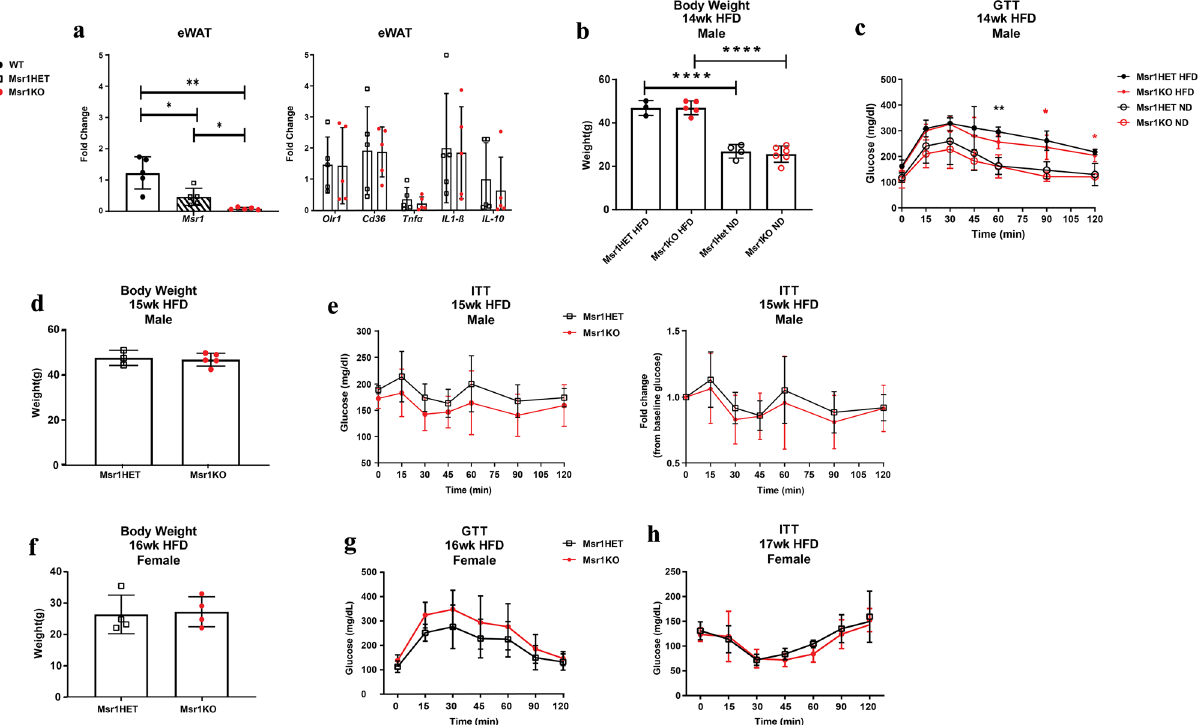
Figure 3. Msr1 is not required for obesity-induced changes in glucose metabolism ( a ) Gene expression of Msr1, scavenger receptors, and cytokines in iWAT and eWAT by qPCR from male Msr1HET (black) and Msr1KO (red) male mice. n = 5/group. * p < 0.05; Statistical Analysis = t-test. WT mice were non-littermate HFD fed controls. ( b ) Whole body weight for 14-week male ND and HFD-fed Msr1HET and Msr1KO mice at the time of ( c ) glucose tolerance test (GTT). ( d ) Whole body weight for 15-week male HFD-fed mice at the time of ( e ) Insulin tolerance test (ITT). n = 3–5 per group. ( f ) Whole body weight for 16-week female HFD-fed Msr1HET (black) and Msr1KO (red) female mice. ( g ) Glucose tolerance test (GTT) and ( h ) insulin tolerance test (ITT) after 16 and 17 weeks of HFD, respectively. HFD Msr1HET (black), HFD Msr1KO (red). n = 4/group. Statistical Analysis for weight = Ordinary one-way ANOVA. **** p < 0.0001 between Msr1KO ND and HFD groups; Statistical Analysis for GTT/ITT = 2-way ANOVA multiple comparisons. ** p < 0.05 between ND and HFD groups of the same